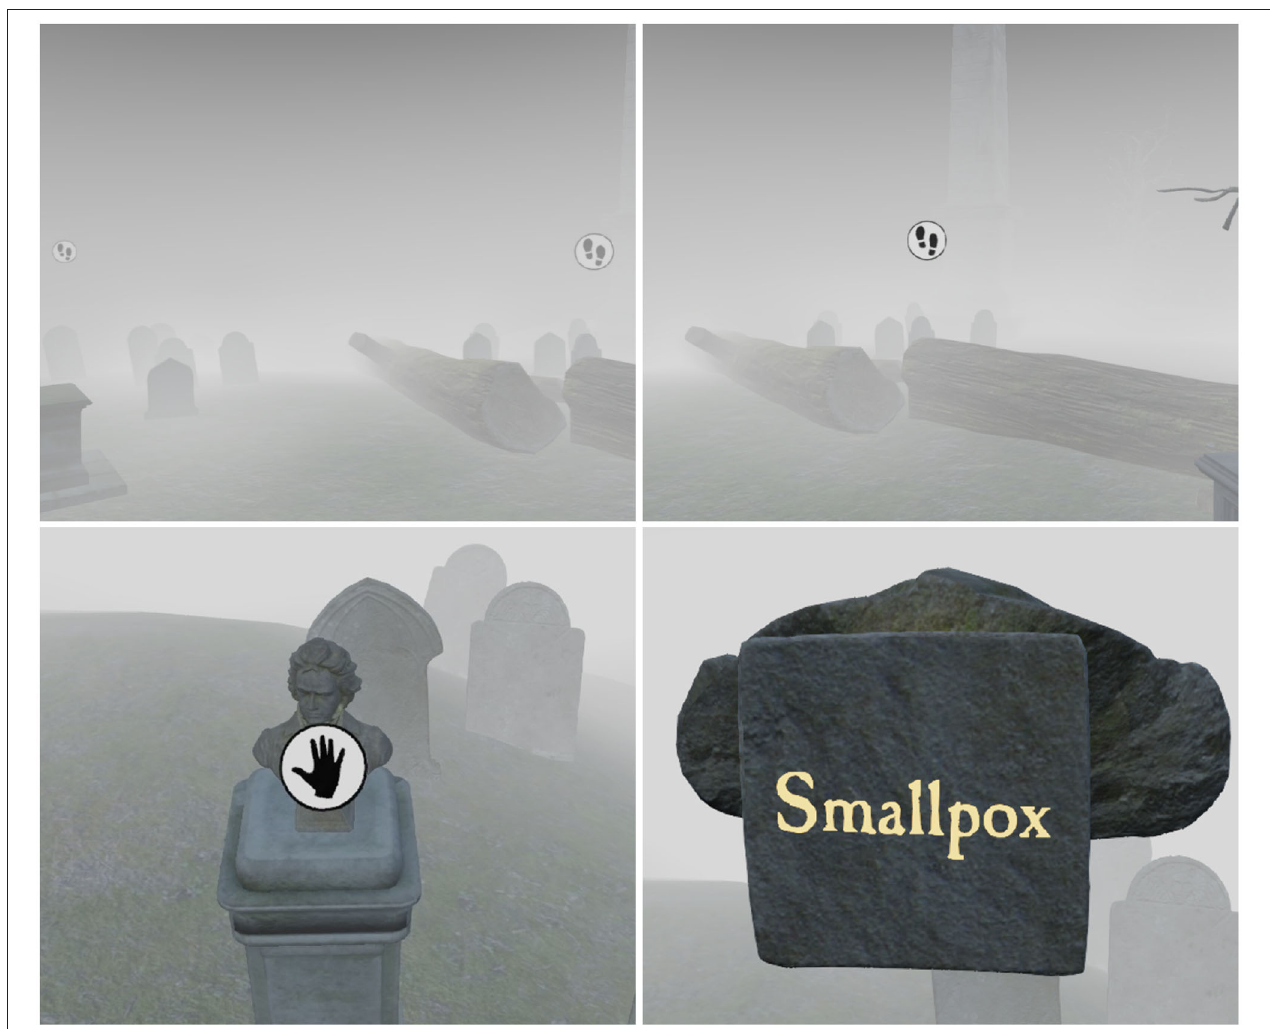
FIGURE 1 | The node-based movement system within “the Chantry” . Players can only move to locations shown by a footsteps icon and pick up items when shown a hand icon. Some objects have a label underneath, or on the back, representing a task.